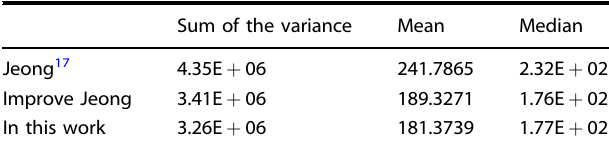
Fig. 4 The in fl uence of high base balance constraint on C and G base contents. Table 1. Sum of variances, mean, and median comparisons of fragments of length 100